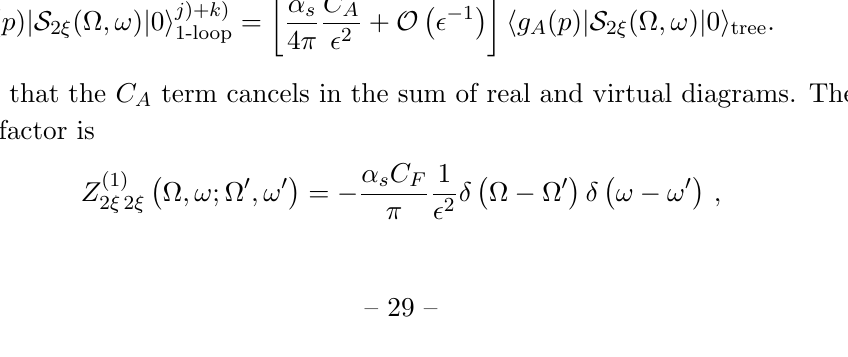
Figure 3 . One-loop virtual diagrams for the one-gluon matrix element of the soft operator obtained from diagrams f i in the following way: each of these diagrams contains two (cid:0) internal gluon lines, one of which is cut. When cutting the other gluon line instead, the corresponding diagrams can be shown to have no 1 =(cid:15) 2